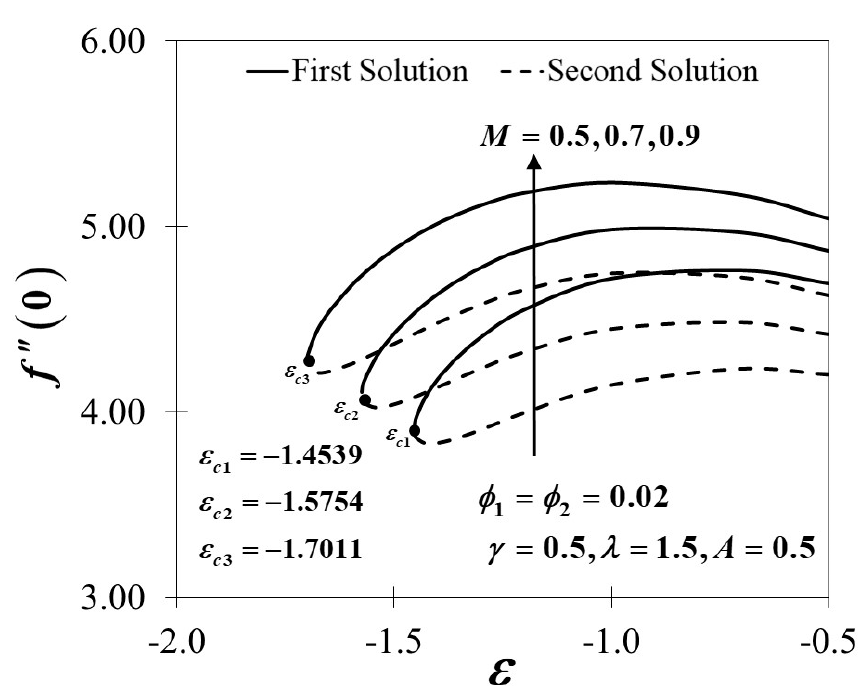
Figure 9. Variations of − θ (cid:48) ( 0 ) for di ff erent values of φ 2 .